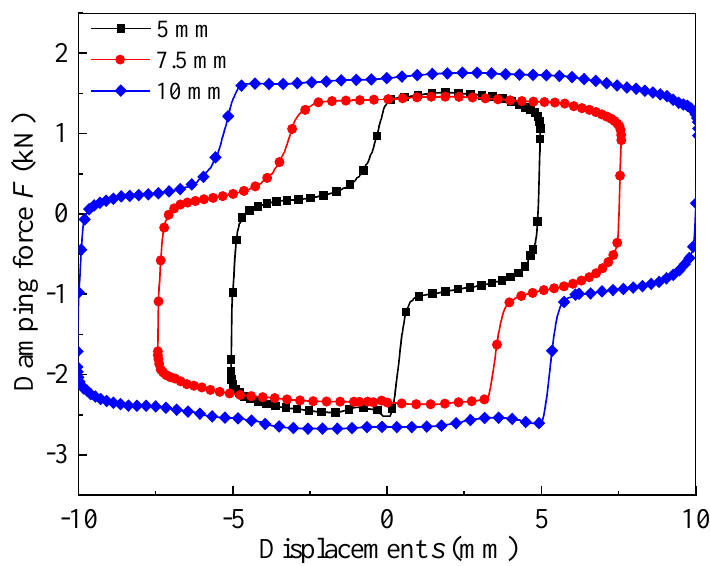
Figure 30. Variation of damping force relative to displacement under different amplitudes.